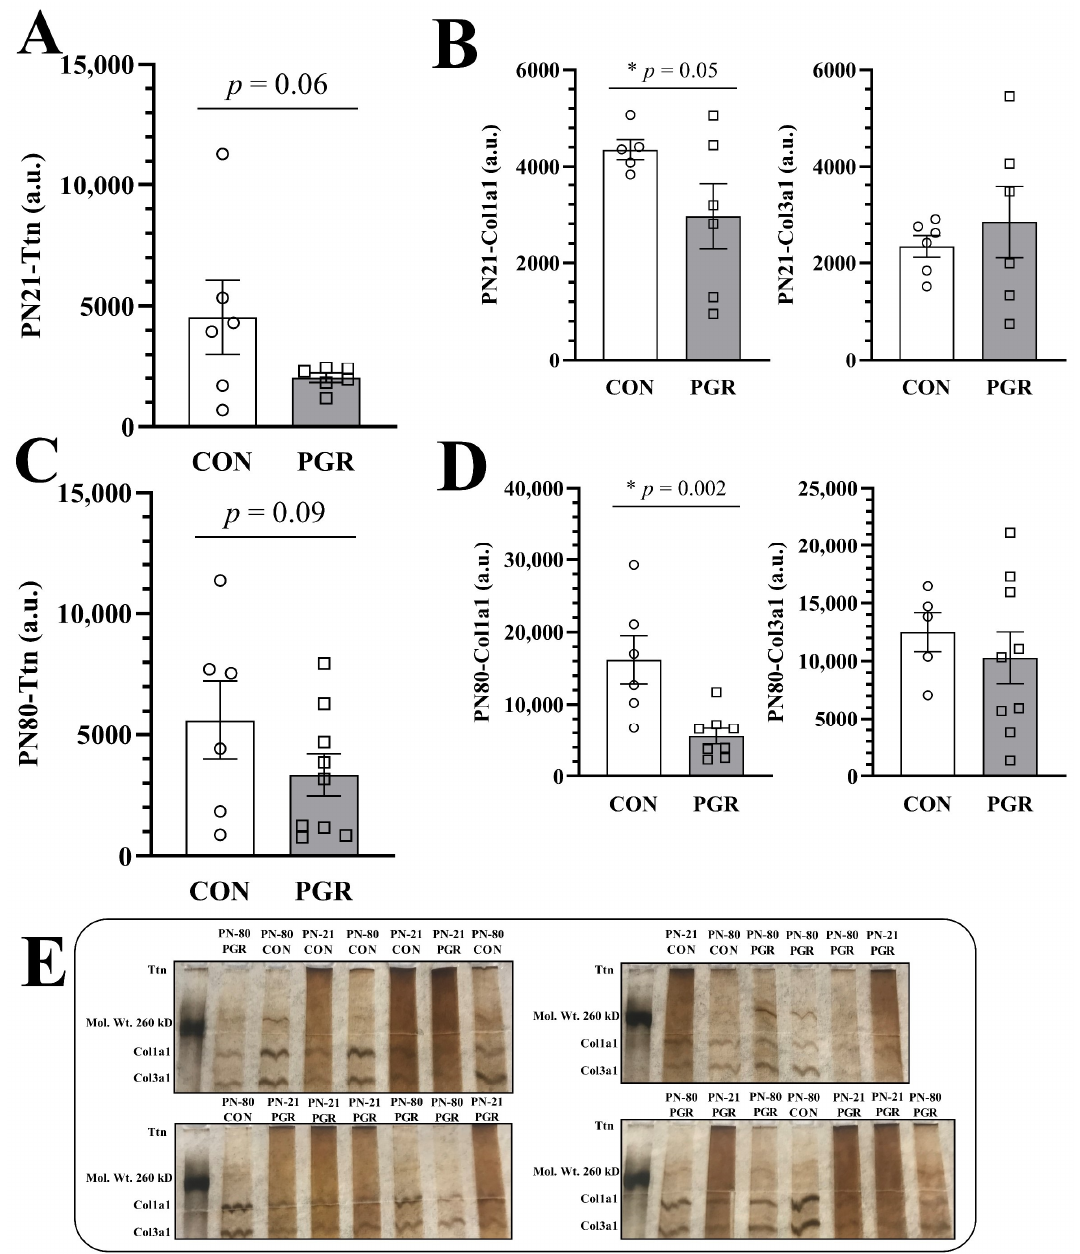
Figure 4. Silver nitrate stain of high molecular weight proteins in CON and PGR mice. ( A ) PN21-PGR- Ttn abundance ( n = 6) was less than CON abundance ( n = 6), but not significantly ( p = 0.06). ( B ) In accordance with 2D-DIGE, PN21-PGR-Col1a1 abundance ( n = 6) was significantly reduced compared to CON abundance ( n = 5), ( p = 0.05), however, there was no significant di ff erence seen in PN21-Col3a1 abundance. ( C ) No significant di ff erences (CON: n = 6, PGR: n = 9). ( D ) PGR-Col1a1 abundance ( n = 8) continued to be less than CON abundance ( n = 5) at PN80 ( p = 0.002). There were no significant di ff erences seen in PN80-Col3a1 abundance. ( E ) Silver nitrate-stained gels; CON and PGR cardiac protein samples (2 µ g) were randomly loaded onto four gels at PN21 and PN80. As no sex di ff erences were seen through two-dimensional di ff erential in-gel electrophoresis (2D DIGE), males and females have been combined into their respective diet groups (CON or PGR). The stain is a contiguous, representative image of CON vs. PGR. Values are mean ±